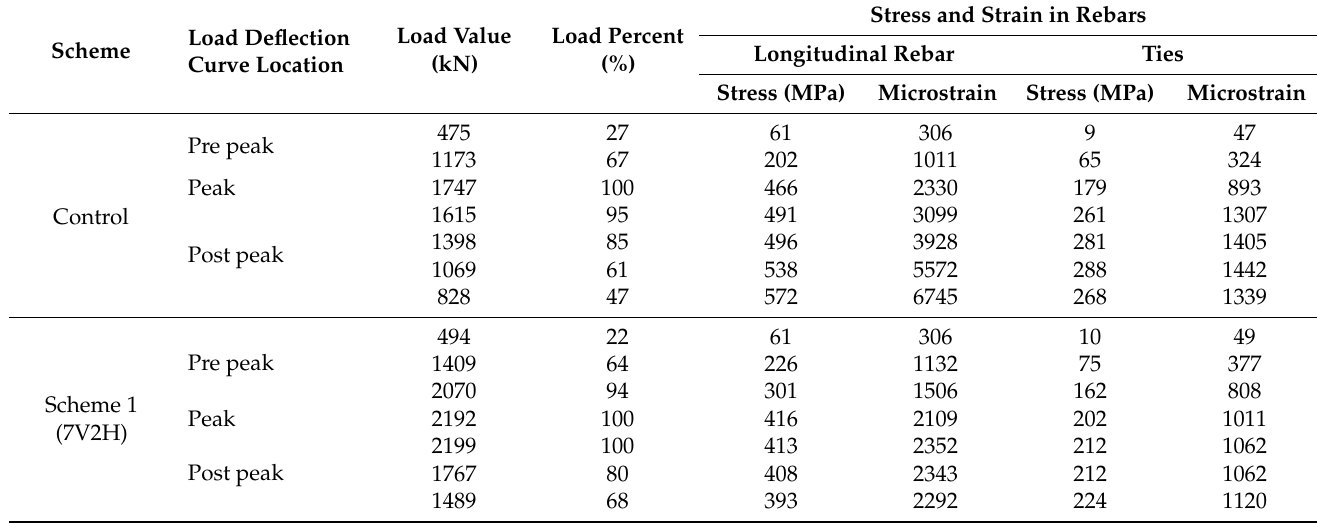
Table 5. Axial compressive stresses and strains at failure location in rebars and lateral